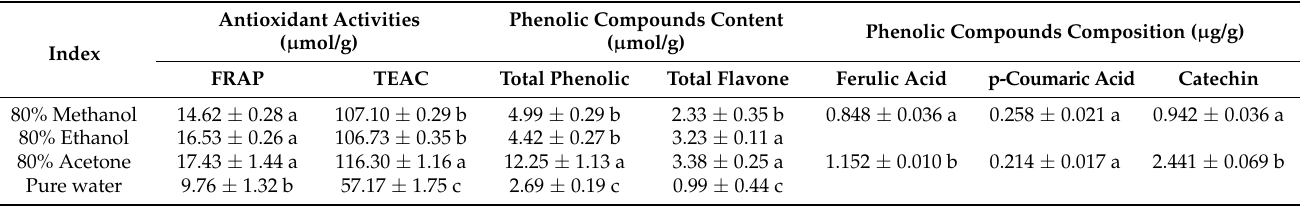
Table 1. Antioxidant activities, phenolic compound content, and main compositions in highland barley flour extracted by different